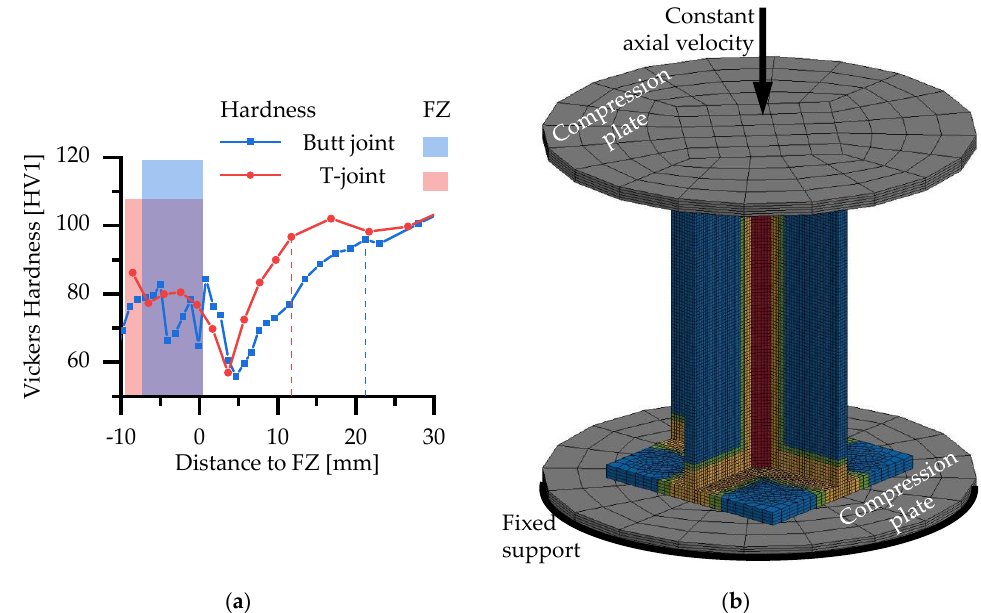
Figure 16. ( a ) Comparison of hardness in a butt weld and T-joint [16]; ( b ) FE model of the axial compression tests with 10-mm plate thickness.